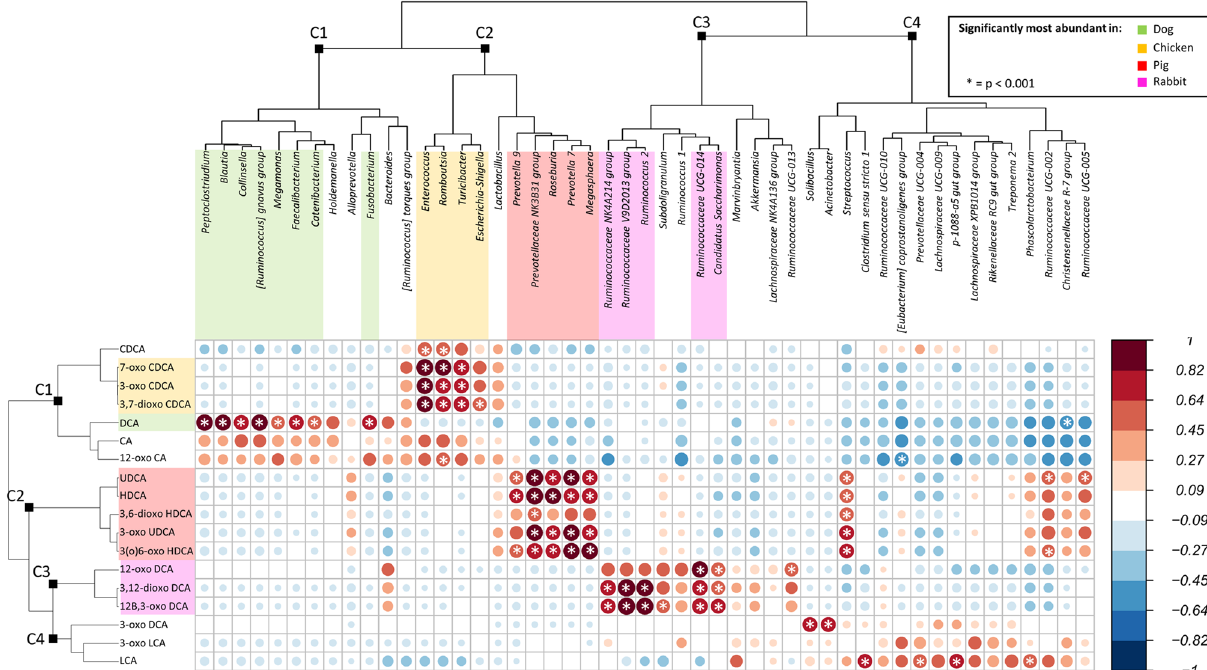
Figure 6. Correlation between animal gut microbiota components and BAs. The color is according to the Pearson correlation coefficients; positive correlations are shown in red, while negative correlations are depicted in blue. The color intensity and the size of the circle are proportional to the correlation values. In addition, a significant correlation was highlighted by a white asterisk in the centre of each circle ( p ≤ 0.001). BA and bacterial genus correlation profiles were clustered using a hierarchical clustering approach, using the profile Pearson correlation value as a similarity measure and Ward’s linkage method. The obtained clusters were represented by dendrograms at the top and left margins of the correlogram. Within each cluster, both BAs and bacterial genera were coloured according to the colour legend in the top right of the figure to highlight the significantly most abundant genus or BA in a specific animal species (see Supplementary Material Figs. S4 and S5).